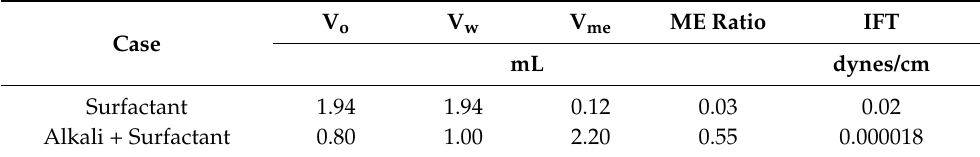
Table 3. Results of phase behavior study for alkali addition to surfactant solution.